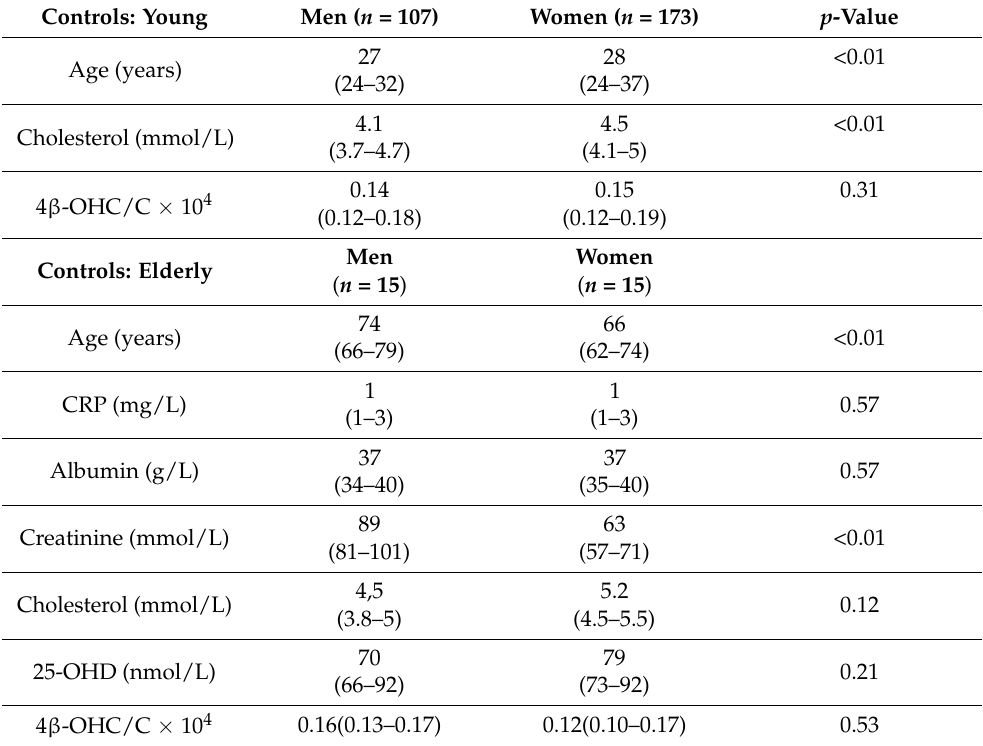
Table 2. Demographic data of the young control populations age 28, 5–35 years ( n = 280) and elderly control population age 60–85 years ( n = 30). Median values and interquartile range (IQR) are presented. Statistical analysis was performed with Mann–Whitney